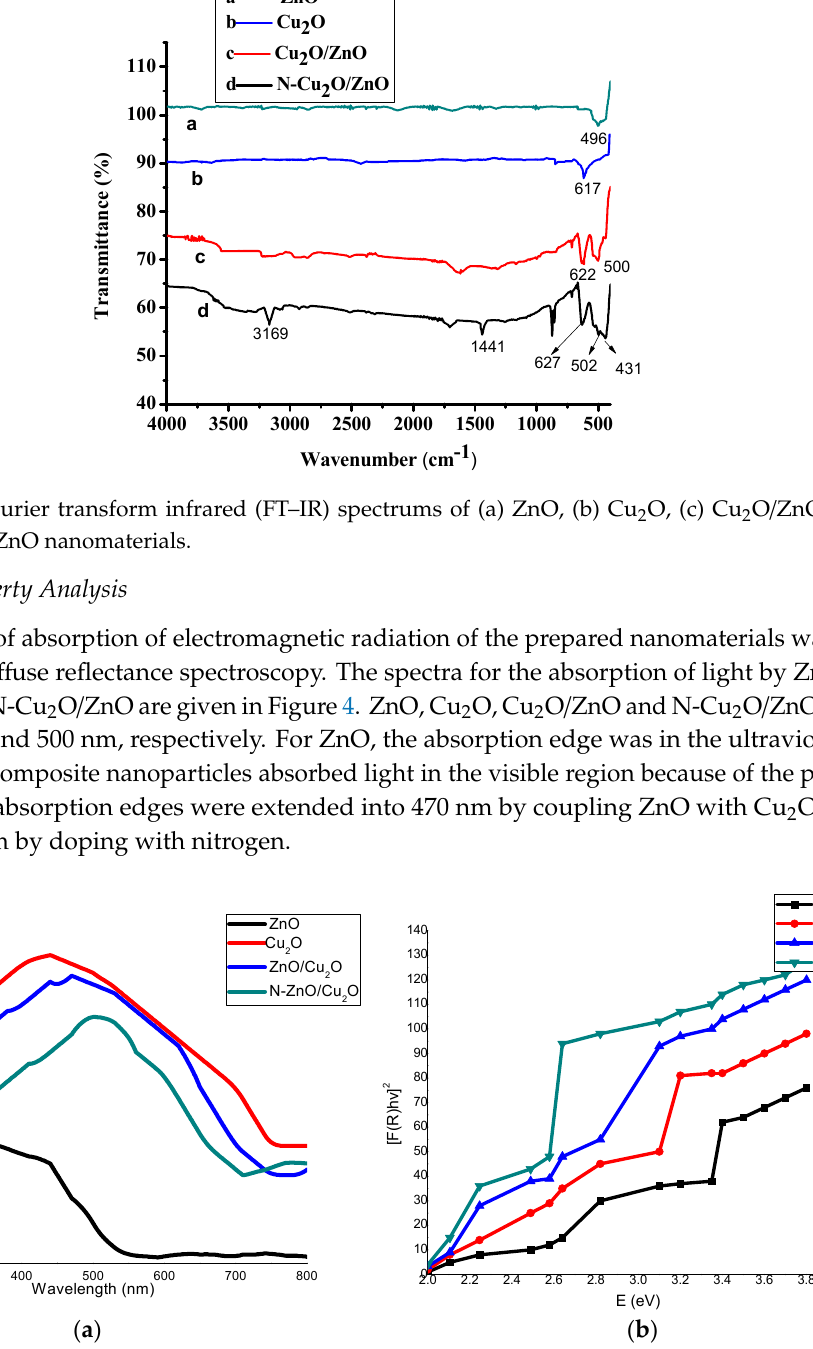
Figure 3. Fourier transform infrared (FT–IR) spectrums of (a) ZnO, (b) Cu 2 O, (c) Cu 2 O/ZnO and (d) N-Cu 2 O/ZnO nanomaterials.